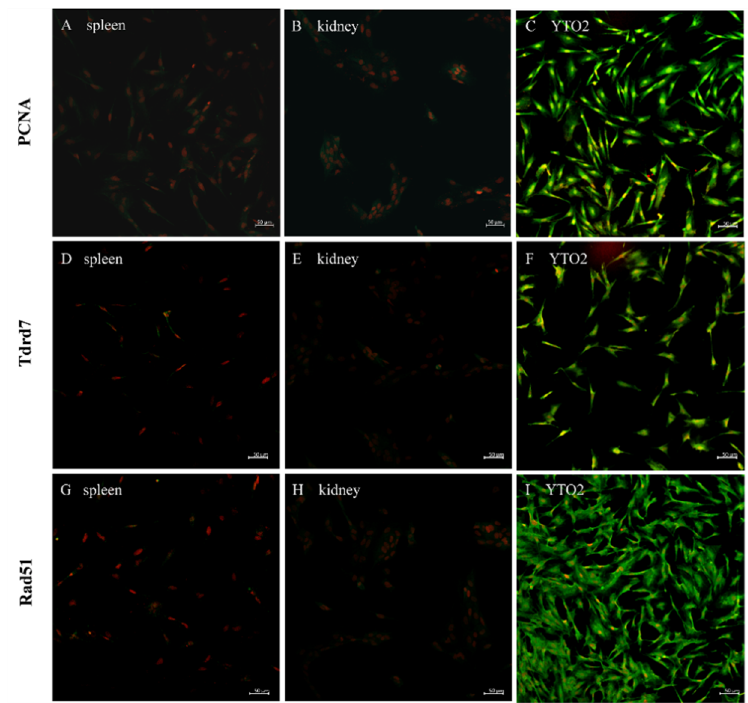
Figure 5. The YTO2 Cells immunostained with pre-immune serum as a negative control. The signals were visualized by TSA green staining (green) ( A , C ) and nuclei were stained red by propidium iodide (PI) ( B , D ). No signal was observed in YTO2 cells immunostained with both mouse serum ( A , B ) and rabbit serum ( C , D ).